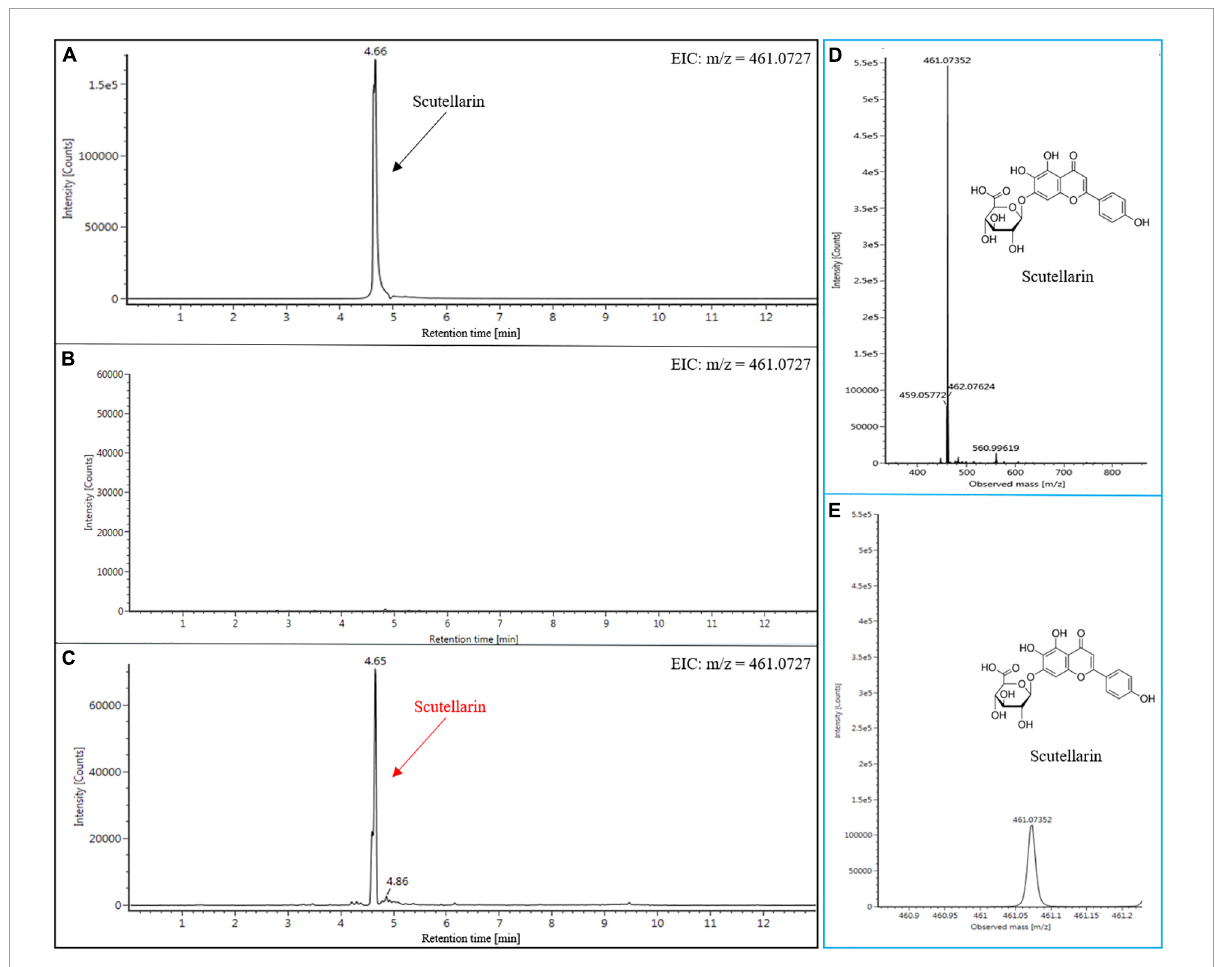
FIGURE6 Heterologous production of scutellarin in N. benthamiana tissues. EIC ( m/z = 461.0727) of scutellarin in standard (A) , WT (B) , and infiltrated N. benthamiana tissues (C) . MS fragmentation patterns of (-)-scutellarin standard (D) . MS fragmentation patterns of (-)-scutellarin in N. benthamiana infiltrated tissues (E)